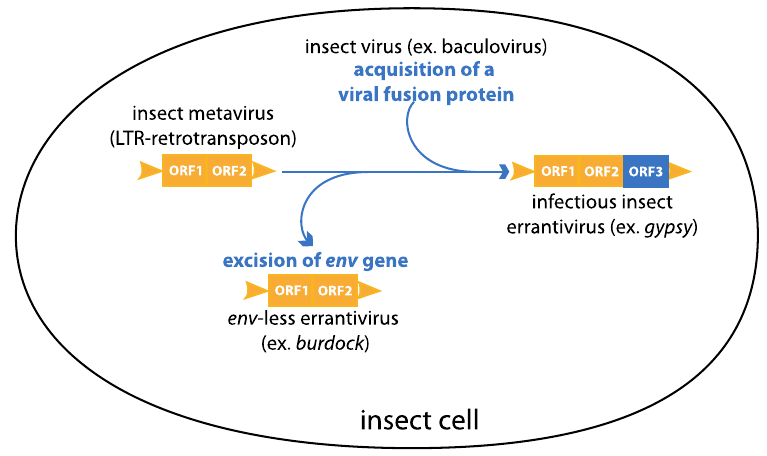
Figure 6. A model describing the dynamic of acquisition and excision of an env gene in errantiviruses Identification of an errantivirus, burdock , closely related to gypsy but lacking an envelope